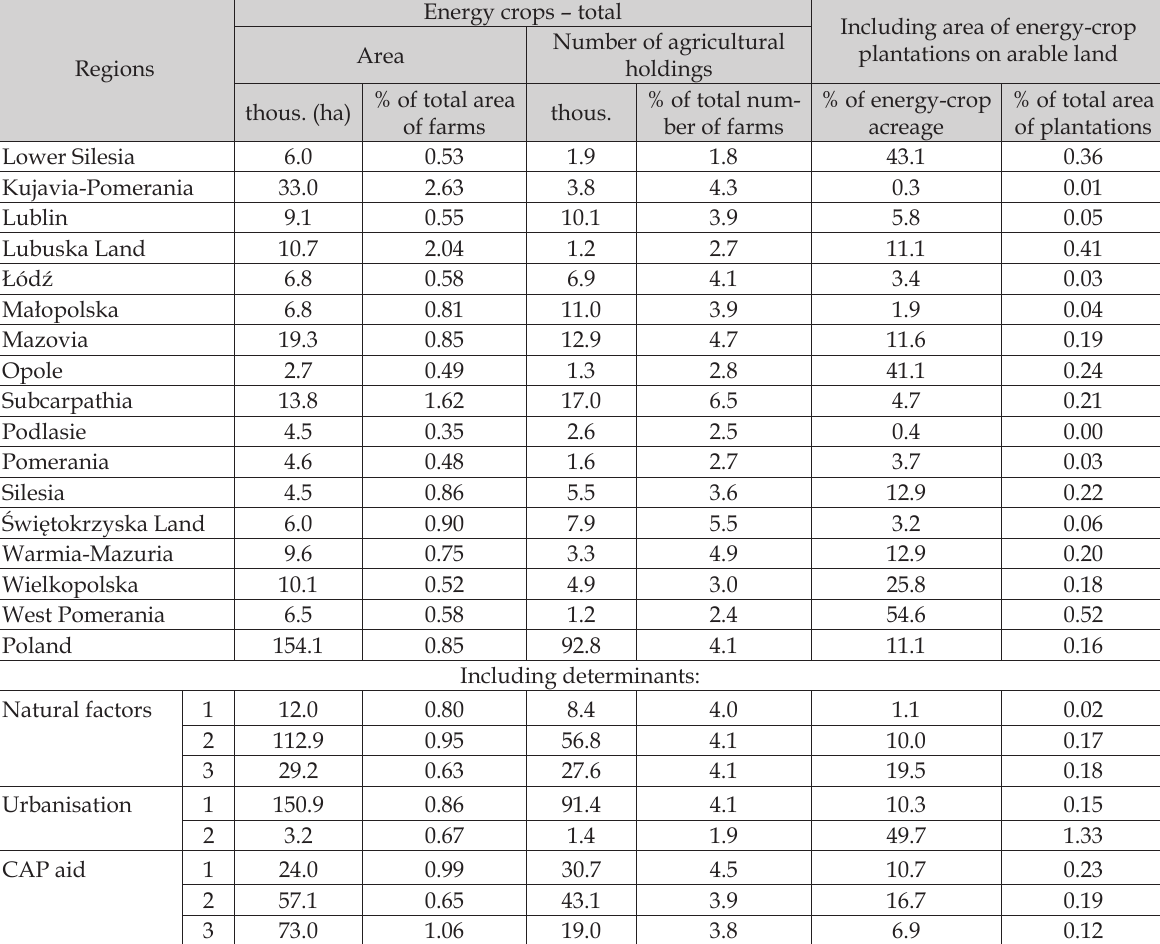
Table 1. Energy crops on Polish agricultural holdings in 2010 – selected parameters. Energy crops – total Including area of energy-crop Number of agricultural plantations on arable landArea holdings Regions % of total area thous. (ha) of farms